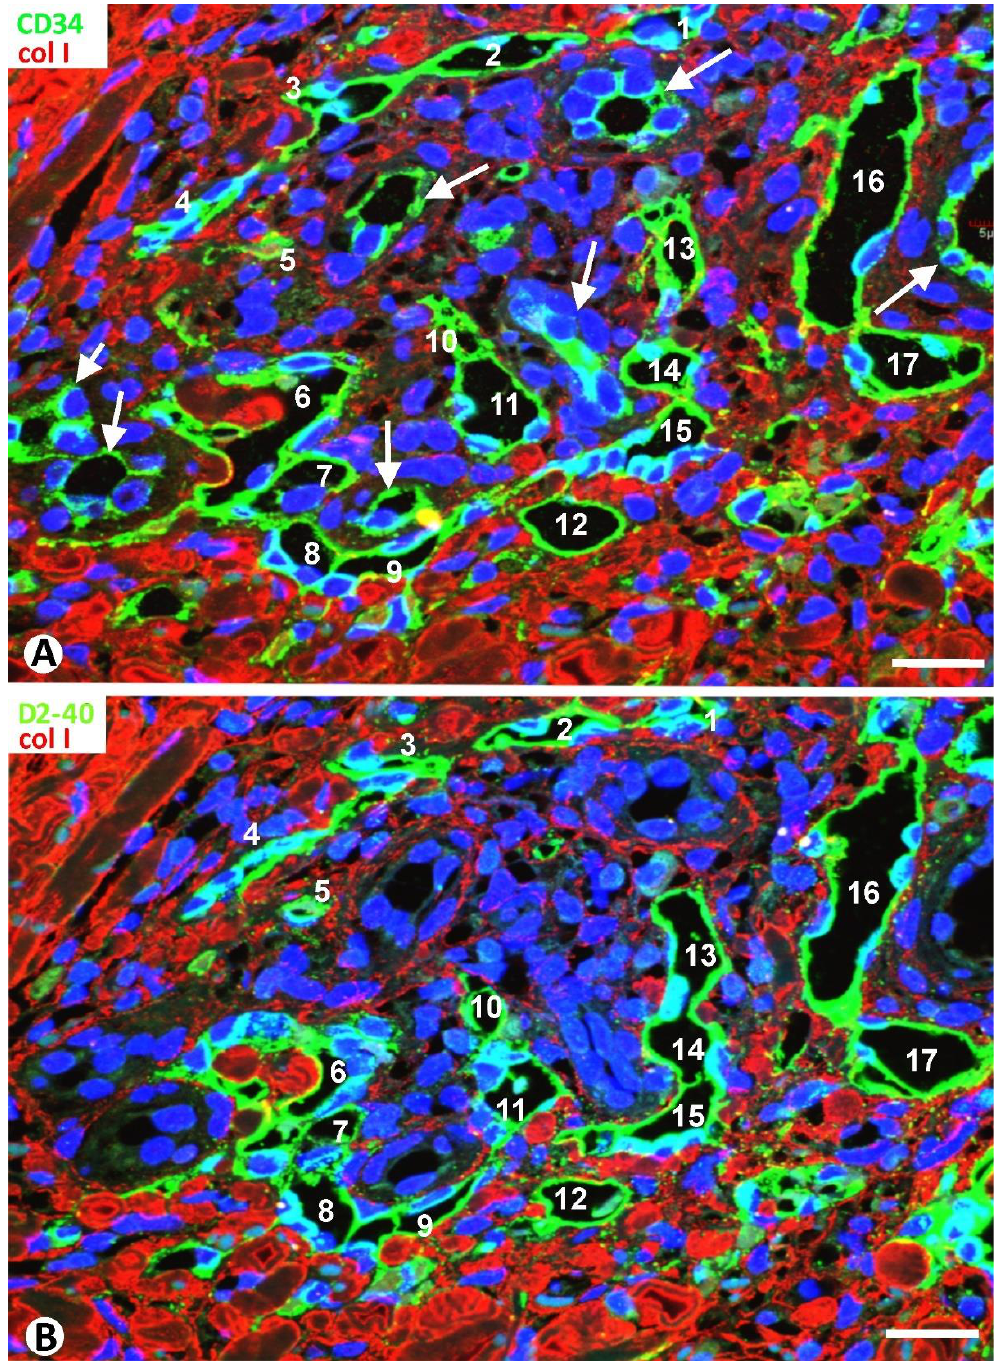
Figure 14. Two images were obtained from serial sections for confocal microscopy, in which the neovessels (1 – 17) are observed expressing CD34 in ( A ) and D2-40 in ( B ), while the pre-existing blood vessels (arrows) are positive for CD34 ( A ) and negative for D2-40 ( B ). Note how the arrangement of neovessels around pre-existing blood vessels is similar to that of CD34+SCs/TCs, as well as the evident neovessel lumens alternating with slit-lumens or small spaces. A discontinuity in the lining and an area of the initial formation of a fold centered by collagen are observed in neovessel 6 in ( A ), while a complete lining and an area of the well-formed fold are present in the same vessel in ( B ). The neovessels 13,14,15 that appear isolated in ( A ) form a continuous lumen in ( B ) as they converge. ( A ): Double immunofluorescence for CD34 (green) and collagen I (red). ( B ): Double immunofluores- cence for D2-40 (green) and collagen I (red). DAPI counterstain. Bar: 40 µm.